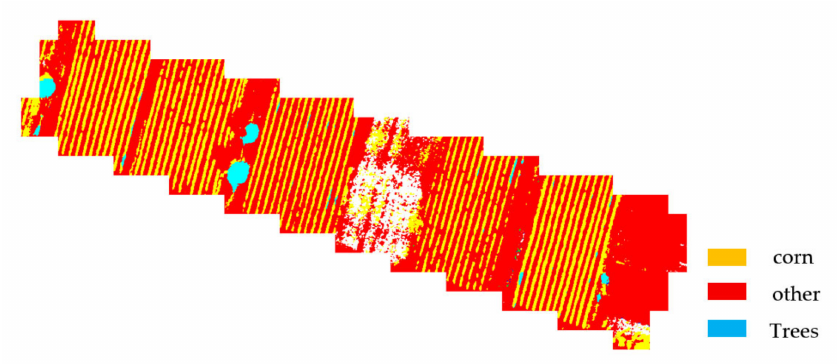
Figure 9. Unimproved DeepLabV3+ segmentation effect.